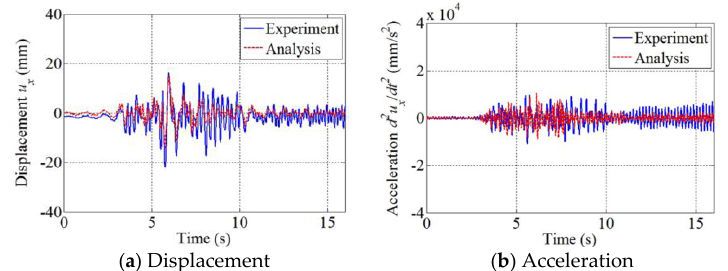
Figure 25. Numerical and experimental responses in the x direction due to the scaled Northridge earthquake of Run 13; responses sampled at point A on the third floor.